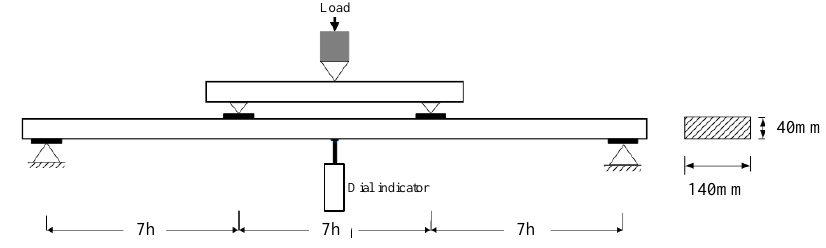
Figure 3. Schematic of the static MOE tests.